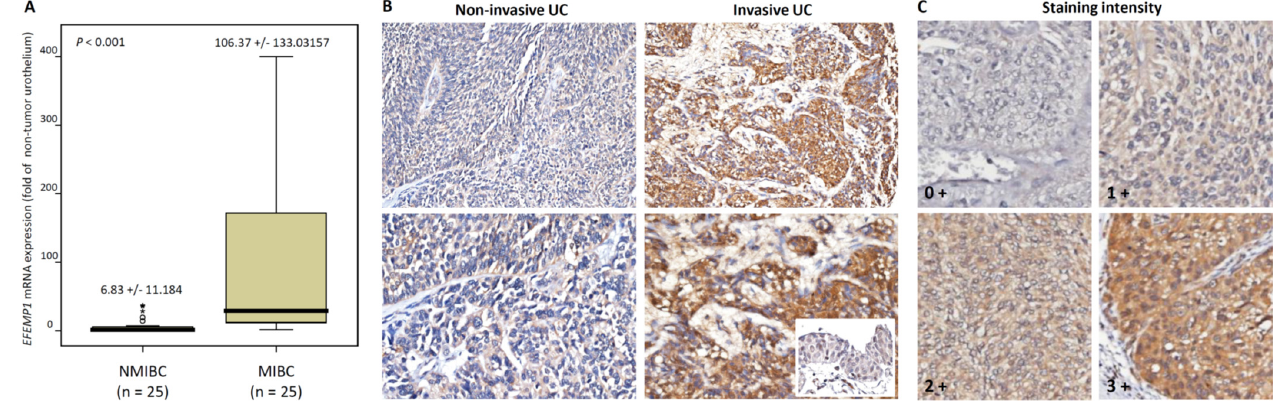
Figure 1. ( A )Expression profiles of genes associated with the progression of urothelial carcinoma (muscle-invasive bladder cancer [MIBC] vs. non-muscle-invasive bladder cancer [NMIBC]; metastasis vs. non-metastasis) from a published transcriptome (GSE31684) in Gene Expression Omnibus. ( B ) EFEMP1 is found to be one of the most significantly upregulated genes.